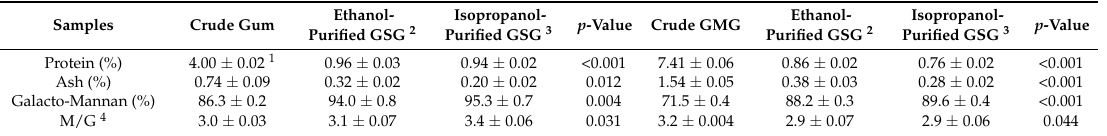
Table 1. Chemical composition of the crude and purified G. sinensis gum (GSG) and G. microphylla gum (GMG), both in ethanol and